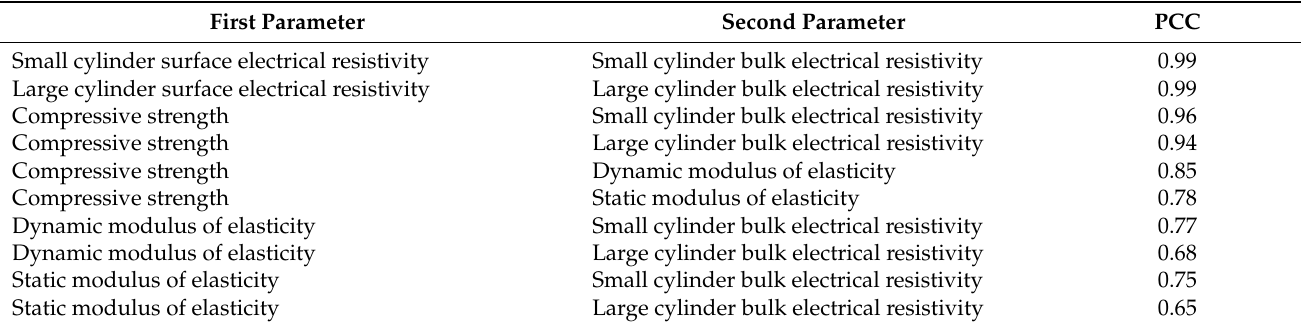
Table 1. Results of the numerical analysis based on Pearson’s correlation coefficient (PCC).